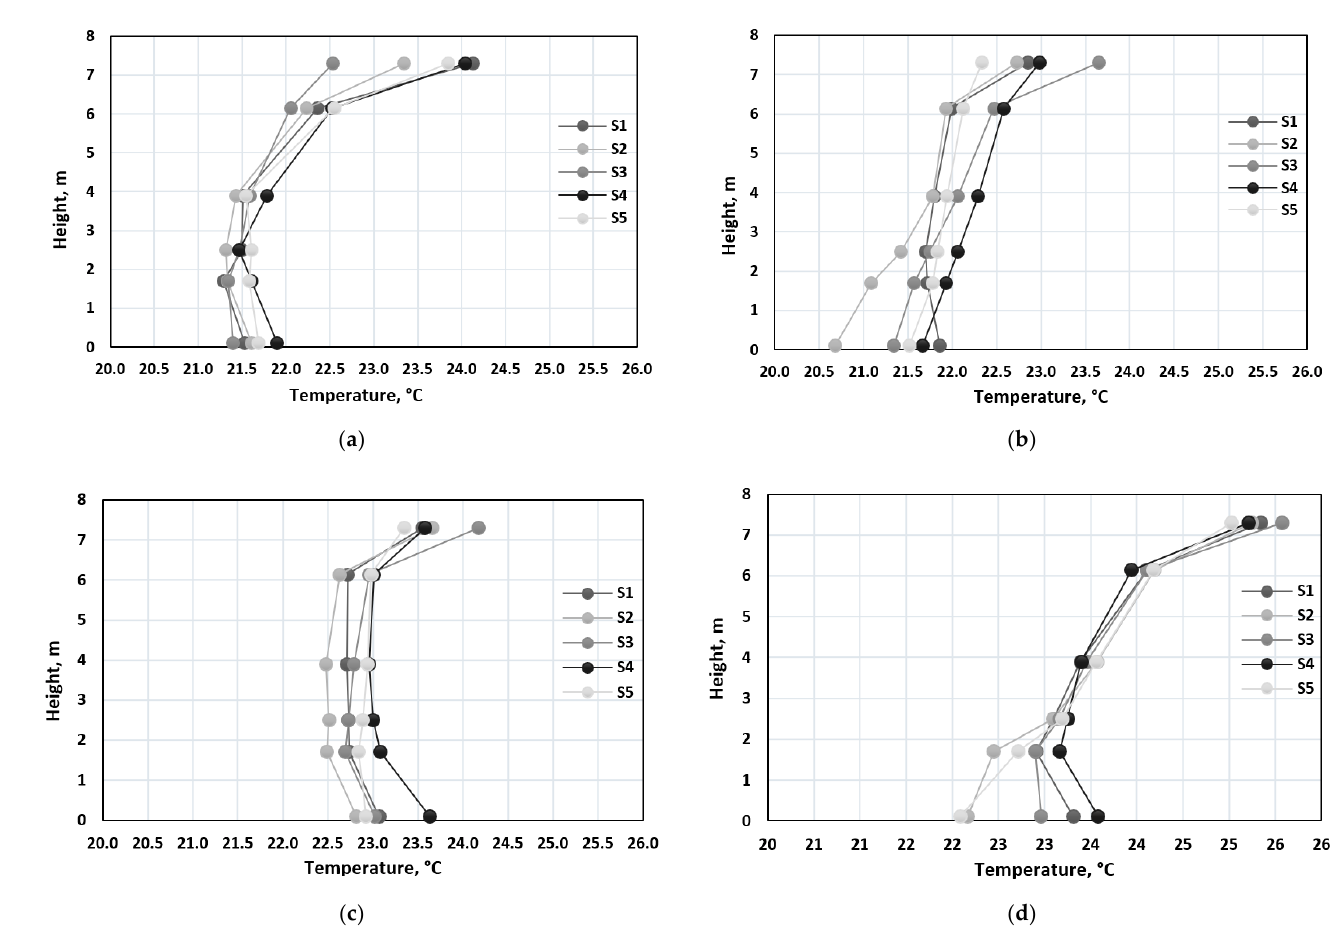
Figure 6. Numerical calculation of the vertical temperature gradient for the case with warm air heating combined with mechanical mixing ventilation from field measurements ( a ), warm air heating combined with mechanical mixing ventilation from CFD predictions ( b ), underfloor heating combined with mechanical mixing ventilation from CFD predictions ( c ), and underfloor heating combined with mechanical displacement ventilation from CFD predictions ( d ).